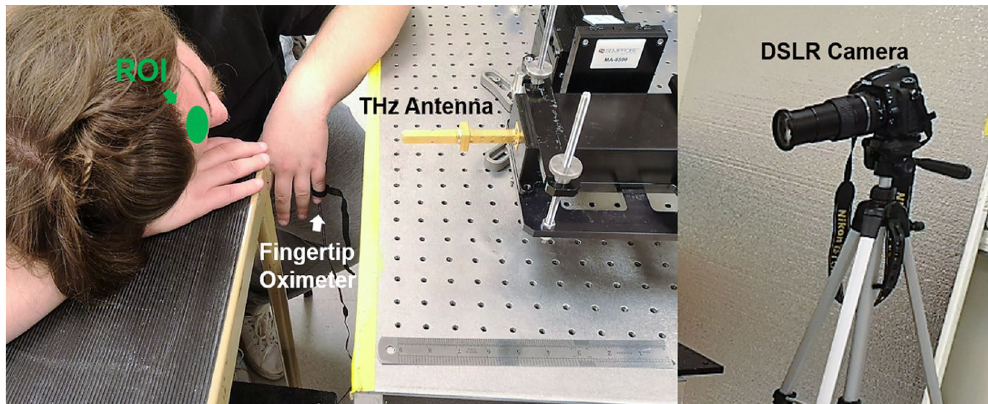
Figure 5. Measurement setup at forehead region of interest (ROI) as indicated in the green area. A fingertip oximeter is used for providing contact PPG signal. Simultaneously, a digital single-lens reflex (DSLR) camera Nikon D750 is focused at the forehead area and recording at 30 frame per second with 1920 resolution. The rPPG signal is extracted by processing the sequence of images.